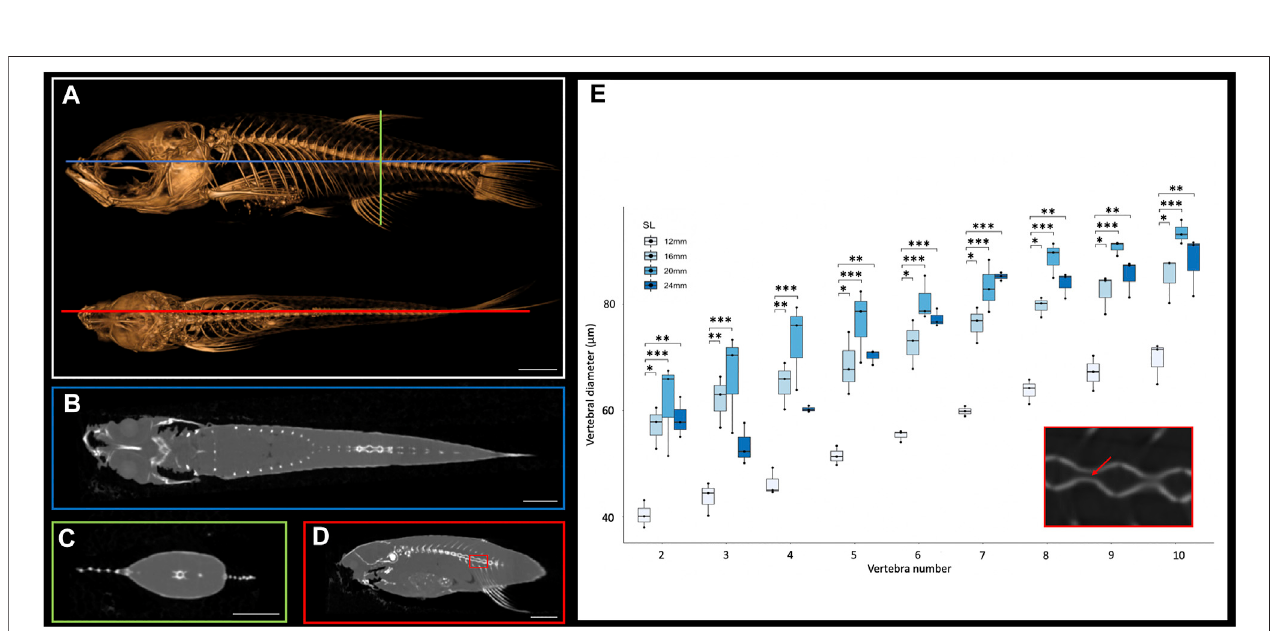
FIGURE 1 | Cross sections of microCT scans visualized in 3D Slicer. (A) , Surface rendering of 24 mm SL adult fi sh with lateral (top) and dorsal (bottom) views with coronal (blue), transverse (green), and sagittal (red) axes indicated. (B) , Coronal cross section image. (C) , Transverse cross section image. (D) , Sagittal cross section image. (E) , Quanti fi cation of vertebral canal width of 3 individual 24 mm SL adult fi sh; each individual differentiated with different shapes (circle, square, triangle). Inset shows higher resolution image through vertebrate (corresponding to the boxed detail in panel D). Red arrow indicates a canal from which interior width was measured. Scale bars, 2